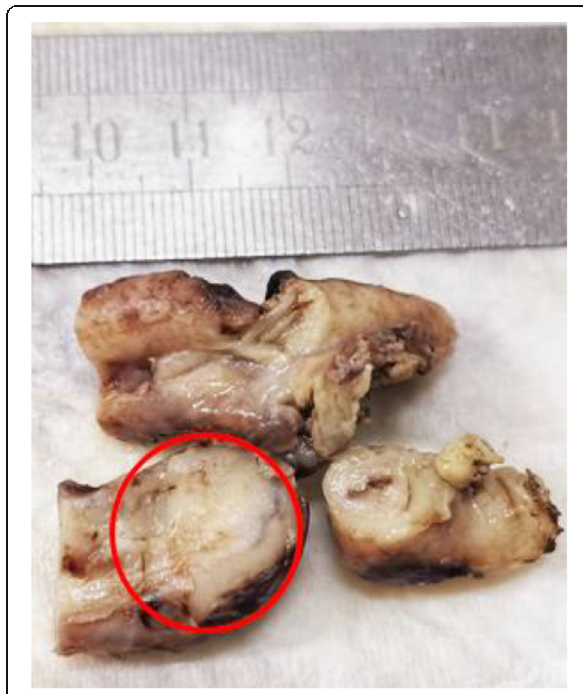
Fig. 1 The appendix specimens: stiff texture and luminal occlusion of the appendix blind